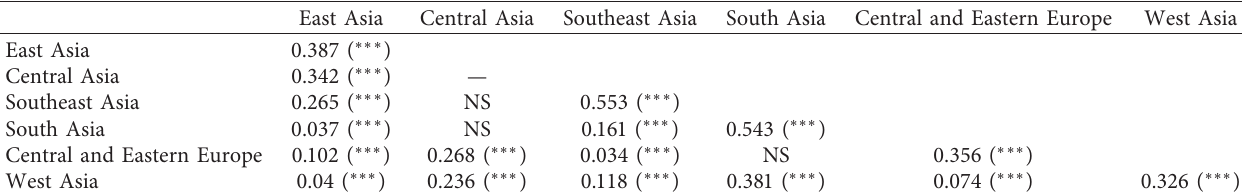
Table 4: Adjusted R -squared for the gravity model within and between subregions.